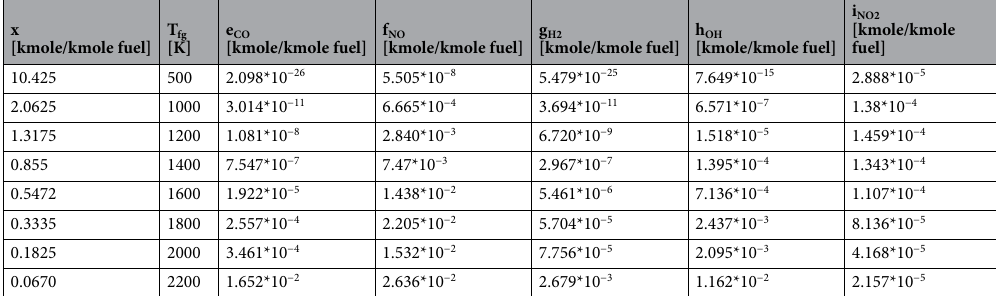
x [kmole/kmole fuel]